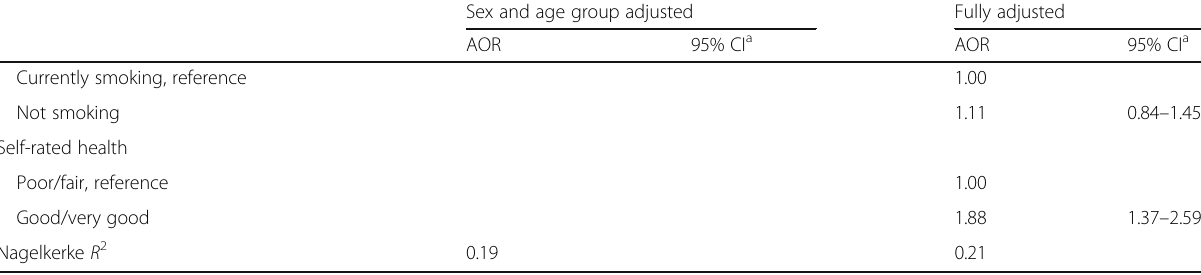
Table 3 Binomial logistic regression analysis related to flourishing mental health ( n = 7012), Tsukuba, Japan (2017)